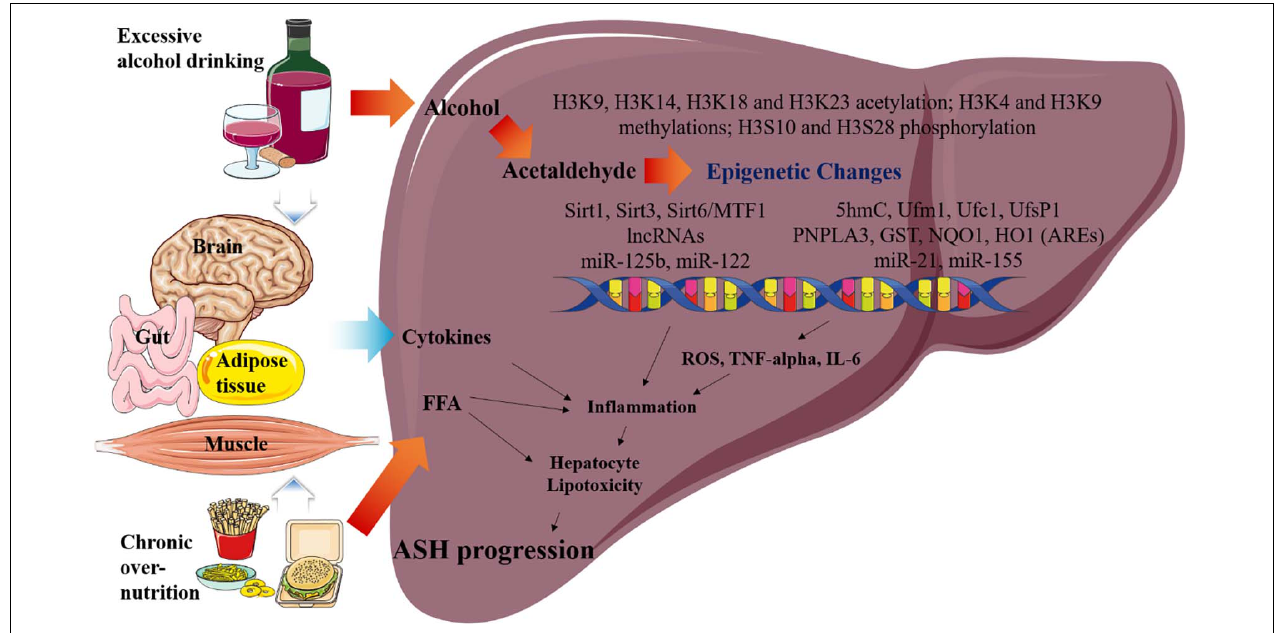
FIGURE 2 | Overview of the epigenetic changes in ASH. Metabolic pathways regulated by acetaldehyde, cytokine, and FFA are induced by excessive alcohol drinking and chronic over- nutrition. Excessive alcohol drinking and chronic over-nutrition synergistically induces ASH progression via activating several different signaling pathways in the liver, including epigenetic changes. Additionally, hepatic cytokine and FFA levels of cytokines are induced as a result of the associated multiple organ damages, such as those in the adipose tissue, brain, intestines, and muscles. Eventually, this pathway increases hepatic inflammation and hepatocyte lipotoxicity, which result in the stimulation of